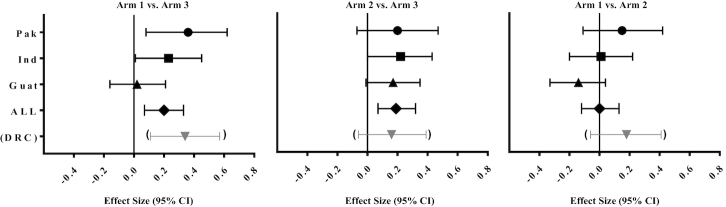
Effect sizes and 95% CIs for pairwise comparisons of the difference in mean length-for-age z scores at birth by treatment arm, by site and for combined sites. Effect sizes with corresponding 95% CIs obtained from linear model, adjusted for clusters. The combined site analysis is adjusted for country and cluster-nested within country. GAA data (31) presented for all individual sites except for the DRC which is not adjusted for gestational age (30). “All” represents combined data from the 3 sites with GAA data available (Pak, Ind, and Guat; n = 459–517 per arm). Sample size for each arm within a site ranged as follows: n = 141–160 (Pak), n = 158–184 (Ind), n = 156–177 (Guat), and n = 183–199 (DRC). DRC, Democratic Republic of the Congo; GAA, gestational-age adjusted; Guat, Guatemala; Ind, India; Pak, Pakistan.